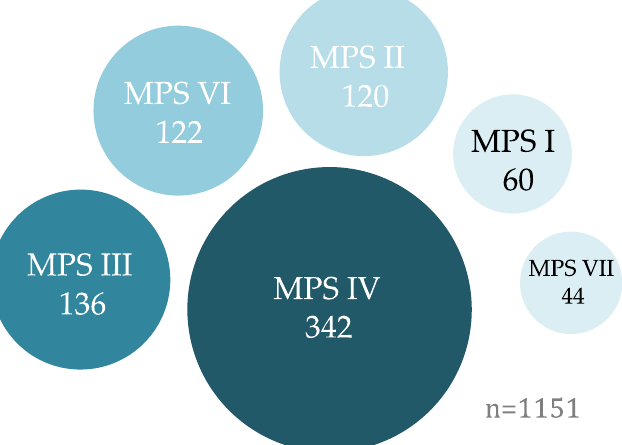
Figure 3. Graphical representation of mucopolysaccharidosis (MPS) mutations as targets for cytidine base editors (CBEs) or adenine base editors (ABEs). A small majority (57%) of known MPS disease-causing mutations ( n = 1151) are currently targetable with existing ABE and CBE systems